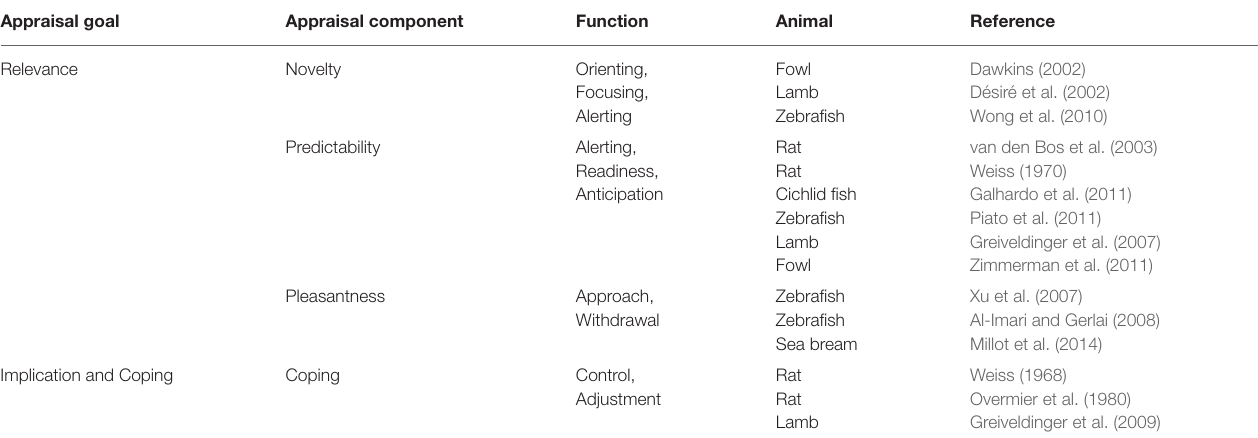
TABLE 1 | Relevant examples of appraisal components in animals